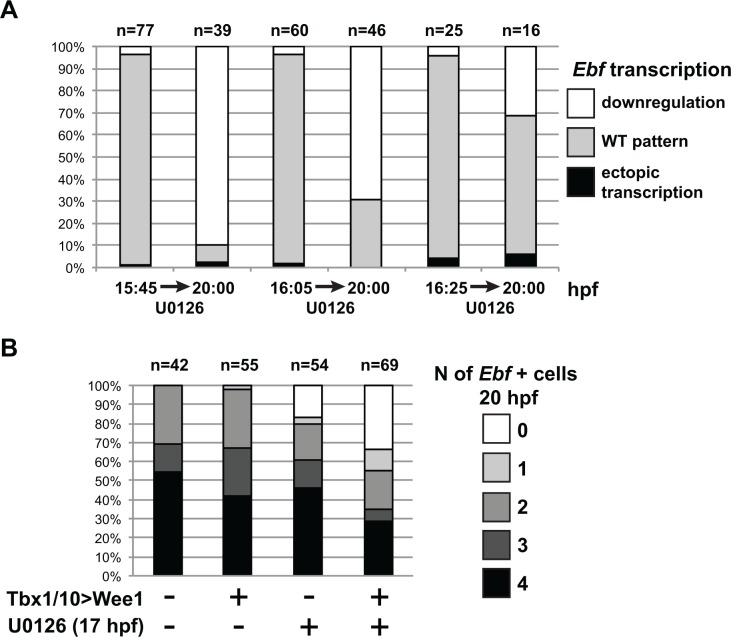
MAPK signaling is necessary for Ebf expression only in early ASMF, and cell cycle inputs shorten the MAPK-dependent period.(A) Proportions of larva halves showing the indicated Ebf transcriptional activity (assayed using intronic probes). Batches of larvae expressing Mesp > H2B::mCherry were split to be fixed for WMFISH or treated with U0126 at three successive time points (15.75hpf, 16hpf or 16.25hpf), and the treated larvae were fixed at 20hpf. This data shows that, although all batches expressed Ebf at the beginning of the experiment, only when MEK was inhibited later (16.25hpf) did Ebf transcription persist in 20hpf larvae. (B) Proportions of larva halves showing the indicated numbers of Ebf+ cells at 20hpf, following expression of the G2/M inhibitor Wee1 in the STVCs, under the control of the Tbx1/10 T12 enhancer (+). Negative controls (-) were electroporated with a Tbx1/10(T12) > Venus construct. Larvae were also treated with U0126 (+) or DMSO (as negative control, (-)), starting at 17hpf, which corresponds to the transition from a MAPK-dependent to a MAPK-independent autoregulative mode of Ebf expression (see Figure 6A). Wee1-induced delays in cell cycle progression increased the sensitivity of late Ebf expression to MAPK inhibition, further supporting the notion that cell divisions accelerate the transition from MAPK-dependent to MAPK-independent self-activating regulation of Ebf transcription.